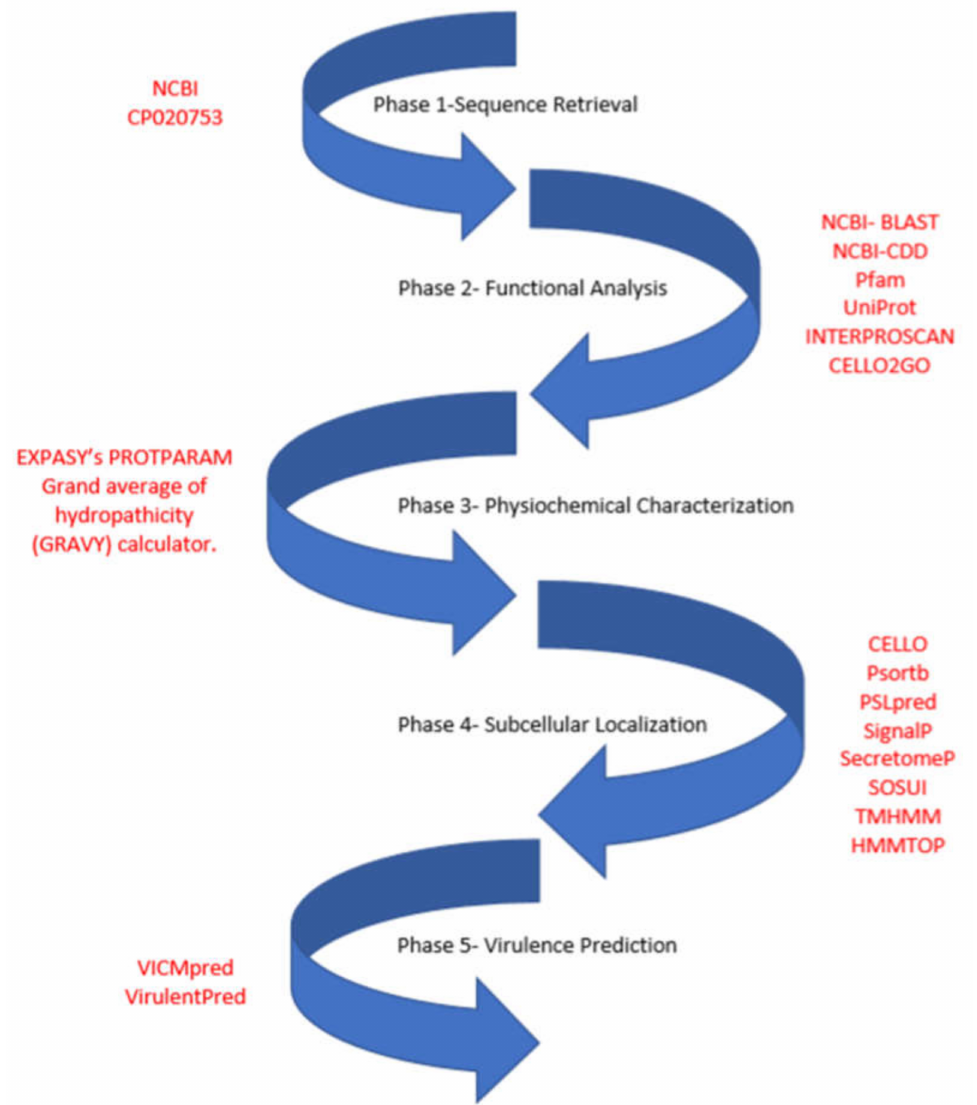
Figure 1. Workflow used for the functional annotation of hypothetical proteins in the Shigella flexneri 1c genome. The entire workflow can be divided into five phases, involving sequence retrieval of the HPs from the genome; functional analysis by identifying conserved domains and GO annotations; followed by analyzing their physiochemical characterization, subcellular localization, and transmembrane helices; and lastly determining if they are involved in virulence of S. flexneri